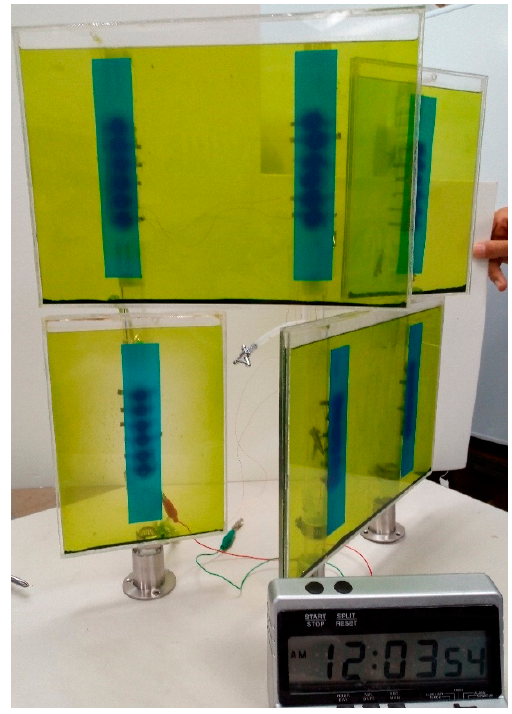
Figure 2. Photosynthetic partition.